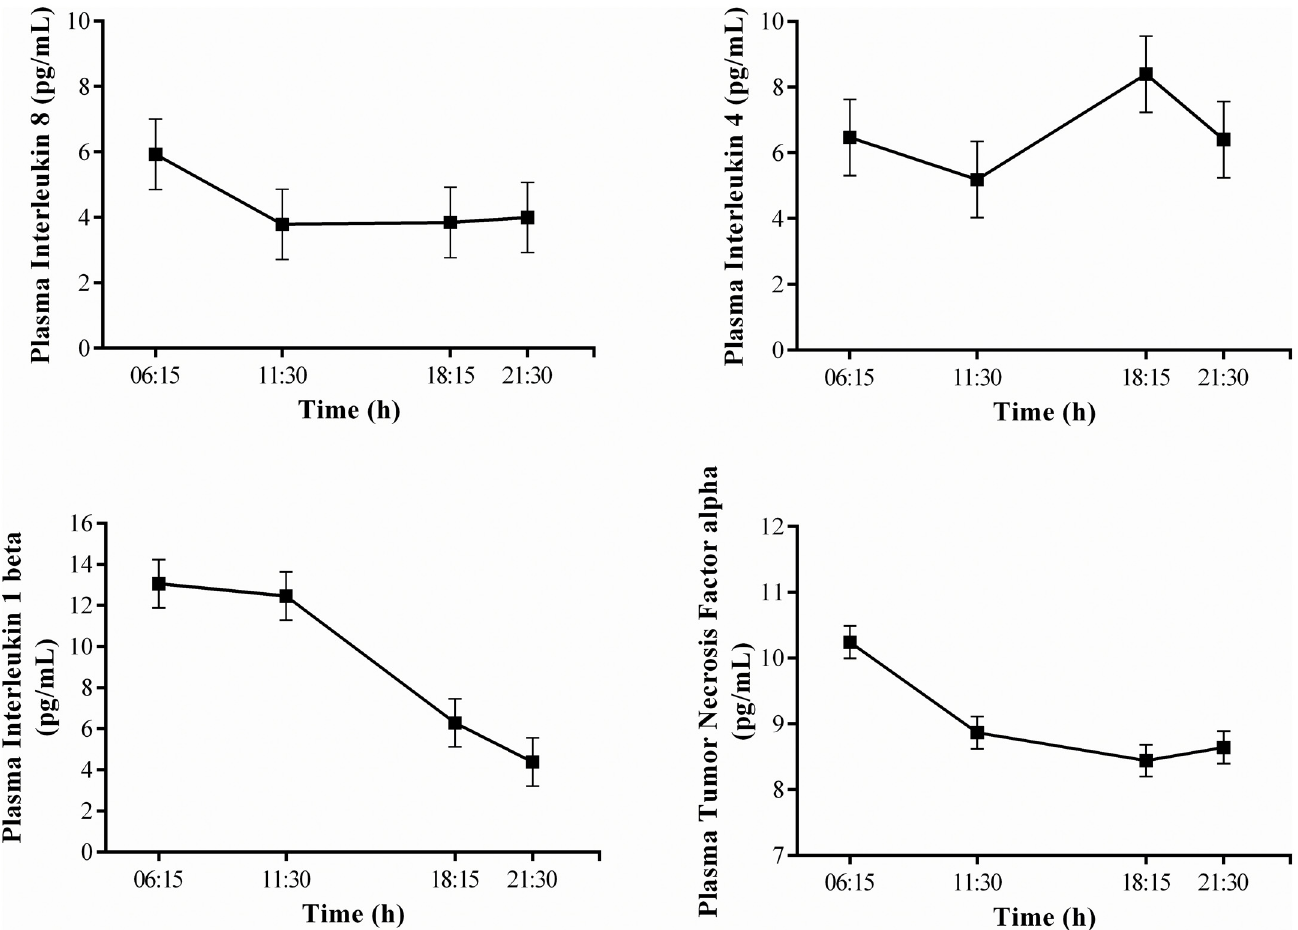
Fig 3. Predicted REML means for IL-8, IL-4, IL-1 β and TNF- α across each daily time-point. Data was log-transformed prior to analysis. For ease of interpretation, values were back transformed to pg/mL.